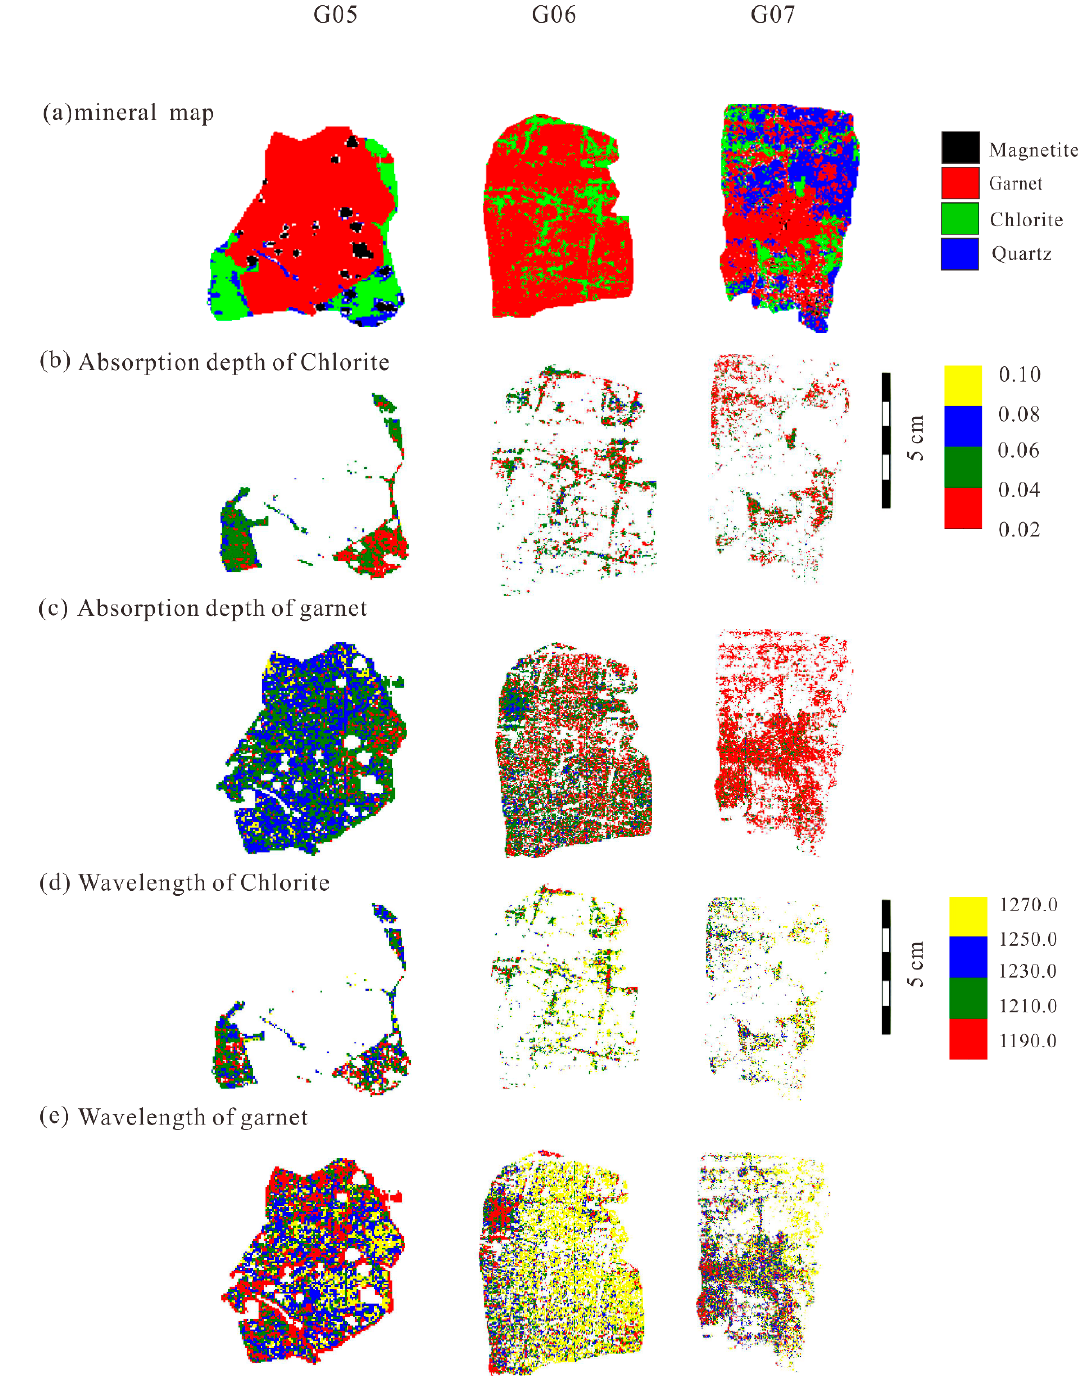
Figure 8. Map of spectral absorption depth and wavelength position at 1200 nm, showing the variability of the alterations in the rock.